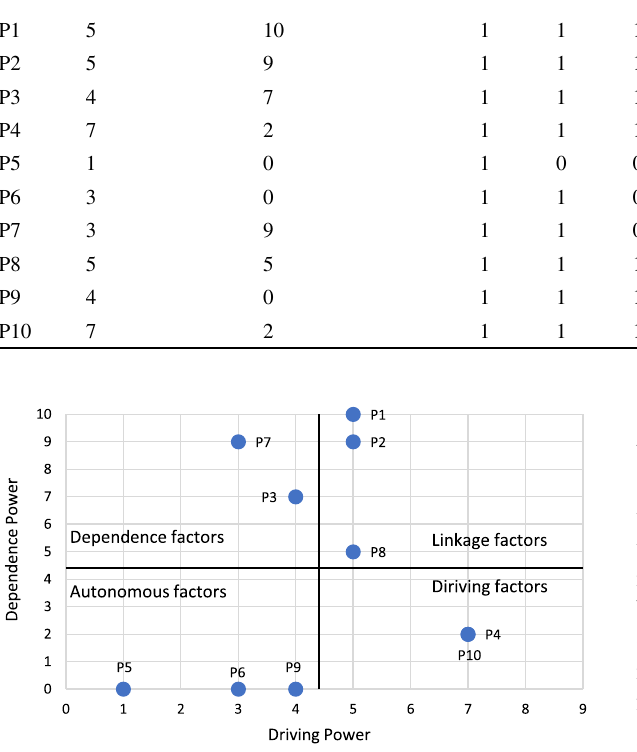
Fig. 2 The driving and dependence power